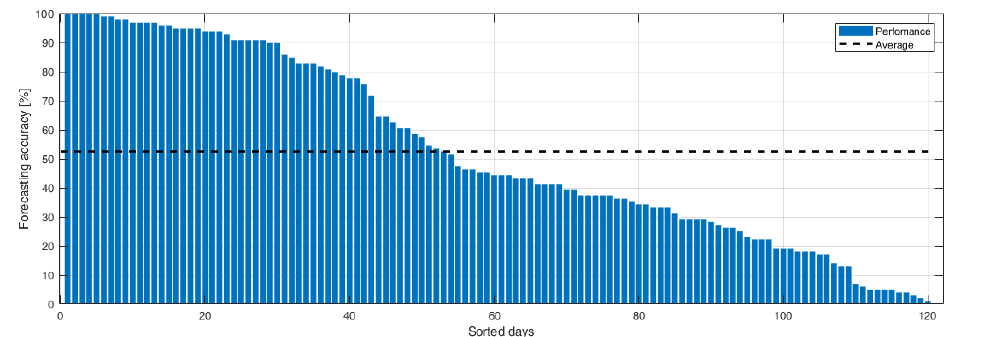
Figure 11. Sorted daily forecasting performance corresponding to a time horizon of 15